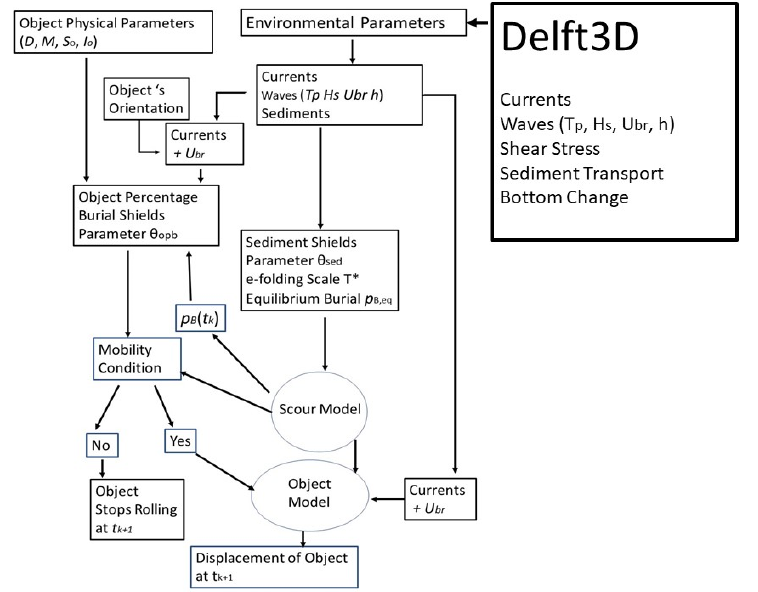
Figure 1. Flow chart of the coupled Delft3D-object model to predict an objects’ mobility and bur-